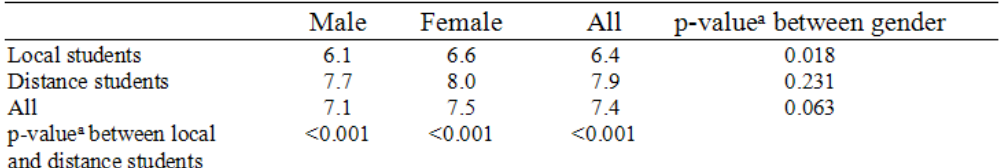
Table 5. The number of semesters students ( N = 161) require to complete bachelor degree in business